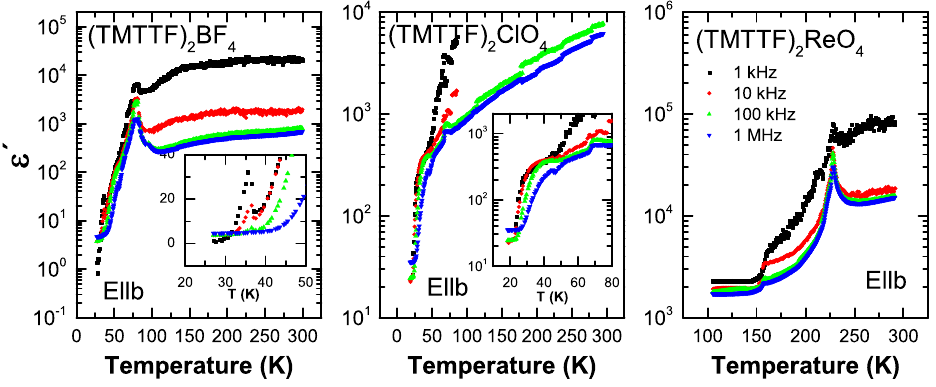
Figure 18. Temperature dependence of the real part of the dielectric permittivity (cid:101) (cid:48) ( T ) measured with E (cid:107) b (cid:48) for (TMTTF) 2 X with X = BF 4 , ClO 4 and ReO 4 at different frequencies as indicated. The insets emphasize the changes close T AO and